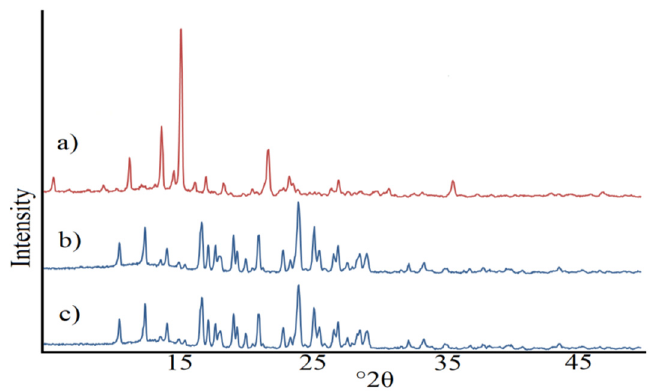
Figure 3. Diffraction patterns of: ( a ) chlordiazepoxide mixture with p -aminobenzoic acid prepared at a 1:1 molar ratio by a laboratory stirrer, ( b ) chlordiazepoxide co-crystals with p -aminobenzoic acid